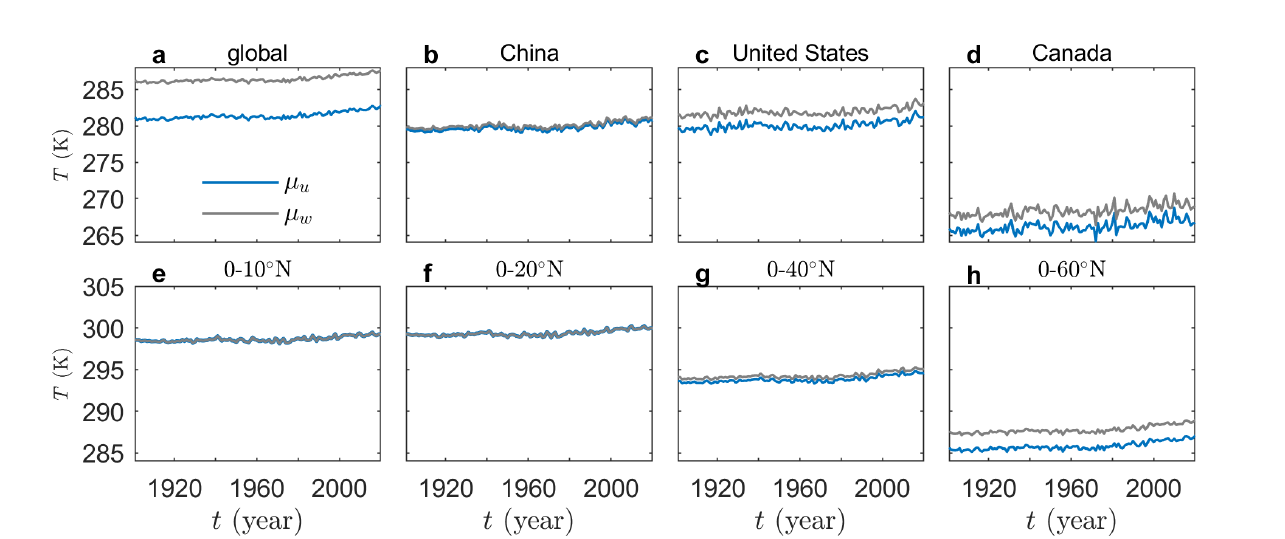
Figure 2. Comparison of weighted and unweighted averages ( µ w and µ u ) of temperature time series ( a ) around the globe, across ( b ) China, ( c ) the United States, ( d ) Canada ( e ) 0–10 ◦ N, ( f ) 0–20 ◦ N, ( g ) 0–40 ◦ N, and ( h ) 0–60 ◦ N using CRU